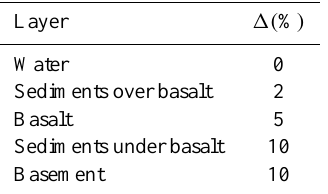
Table 3. Allowed variation to generate modified models for ve- locity, velocity gradient and thickness for every layer in models 1 and 2.